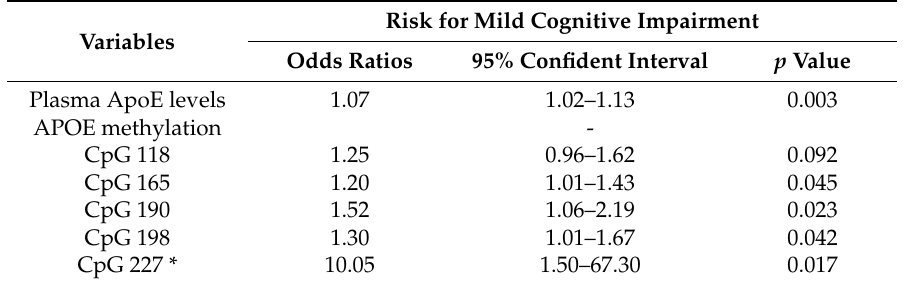
Table 4. Adjusted logistic regression models to examine the association of plasma ApoE levels and APOE methylation with mild cognitive impairment.